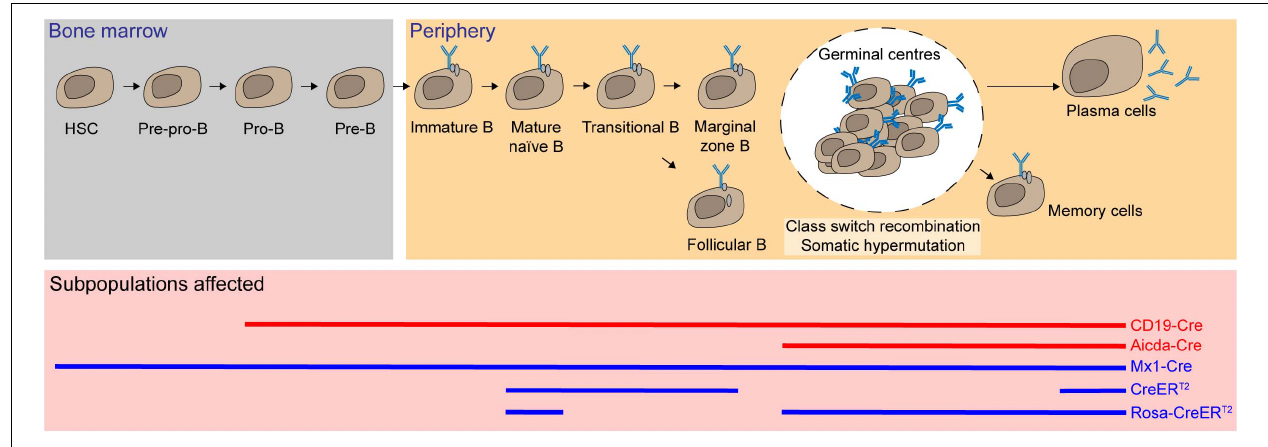
FIGURE 3 | Mcl-1 is an essential pro-survival Bcl-2 protein for hematopoietic stem cells (HSC), progenitor cells, and subsets of B lymphocytes. Using multiple conditional knock-out (red solid line) and inducible conditional knock-out systems (blue solid line), Mcl-1 was found to be crucial for the survival of HSC and all the subsets of B cells, including immature and mature B cells, recirculating B, plasma B, and memory B cells.